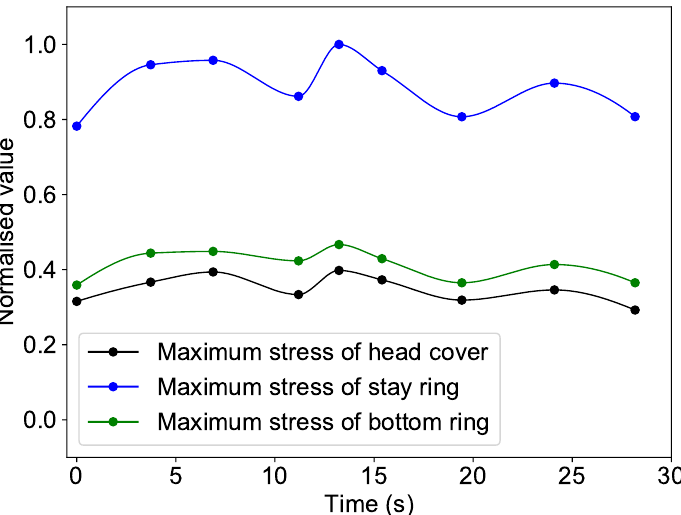
Figure 22. Comparison of the maximum stresses of the stationary structures during load rejection.